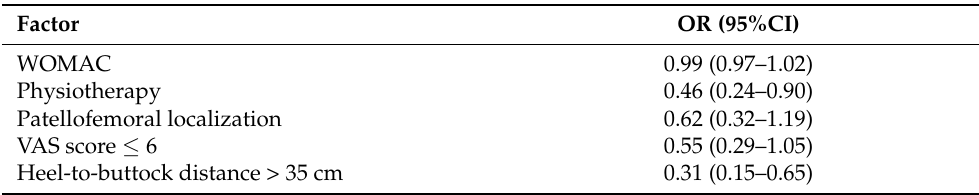
Table 4. Factors associated with response to PRP by multivariable